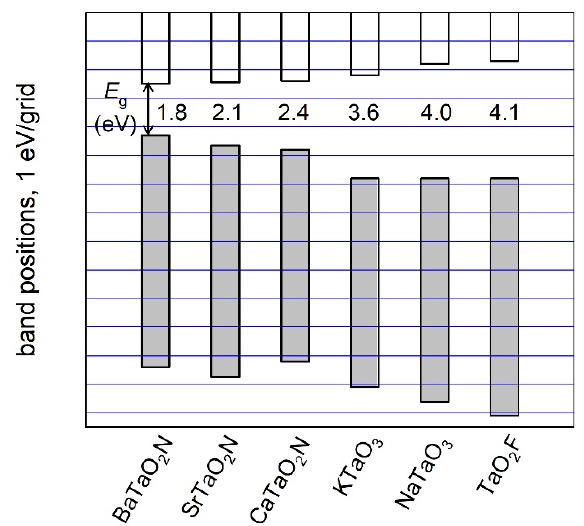
Figure 5. Conduction (unfilled) and valence (shaded) band positions for several simple perovskites with octahedral Ta 5+ , as deduced from diffuse reflection absorbance and XPS measurements.